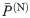
EEG rhythms in the θ and δ bands increased with the control parameter setting.(A) Normalized EEG power P¯(N) as a function of the control parameter setting, separately for the δ, θ, α and β bands. Both θ and δ activity increased as a function of a, whereas α and β did not. (B) Topographical plots of normalized EEG power. Larger oscillations were observed over the frontal region in the δ and θ bands. * represents p < 0.05 and ** represents p < 0.01.